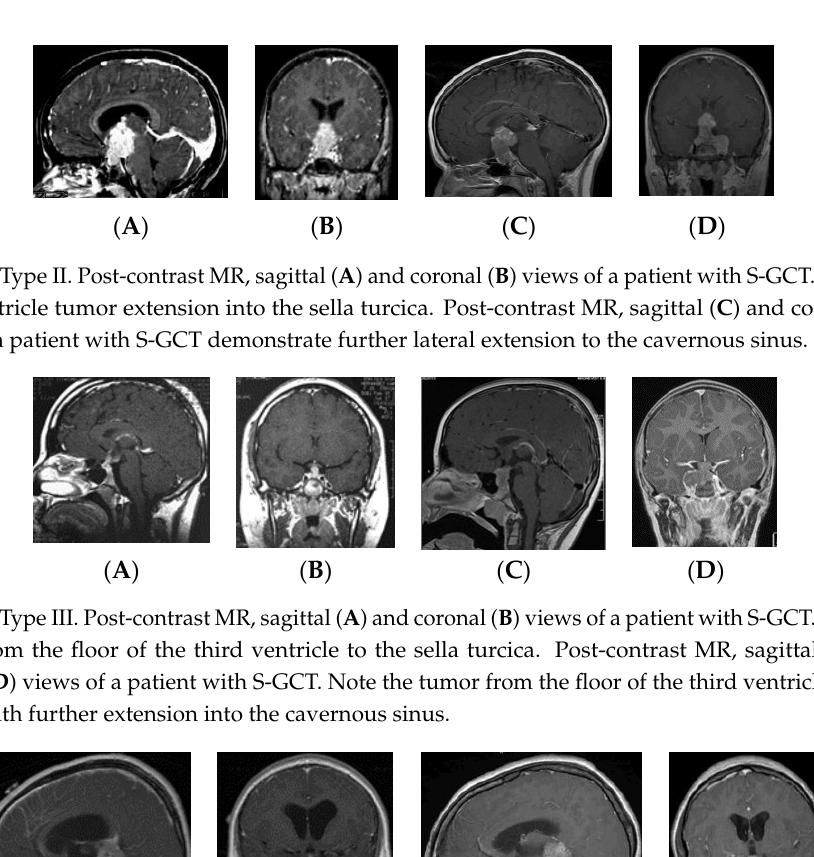
Figure 3. Type II. Post-contrast MR, sagittal ( A ) and coronal ( B ) views of a patient with S-GCT. Note the third ventricle tumor extension into the sella turcica. Post-contrast MR, sagittal ( C ) and coronal ( D ) views of a patient with S-GCT demonstrate further lateral extension to the cavernous sinus.